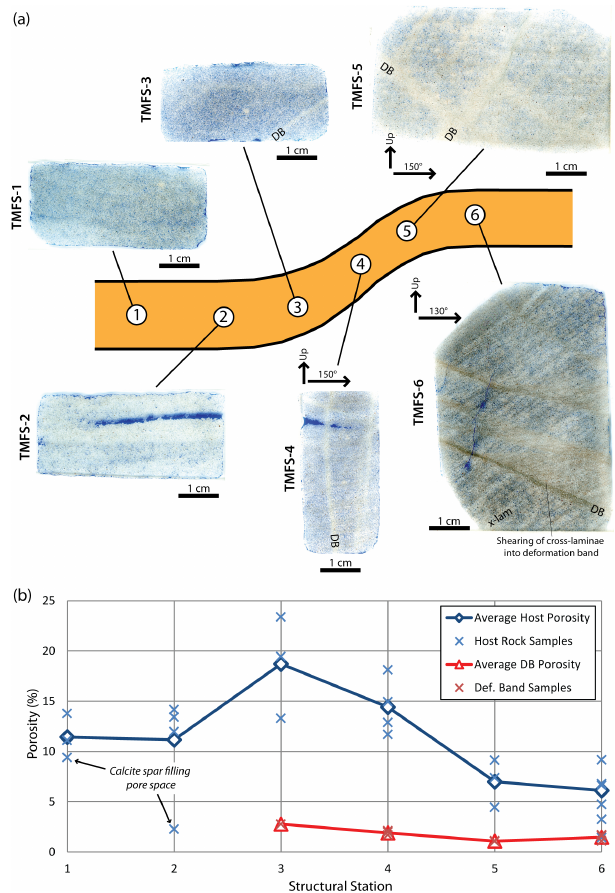
Figure 8. Porosity variability across the intrusion margin. (a) Whole thin-section photographs (flatbed scans) for each structural station. Blue dye denotes porosity in each sample. (b) Plot showing vari- ability in porosity observed in this study for each station. Porosity percentages were calculate using the image analysis software pack- age ImageJ as shown in Fig. 6. Note, a similar porosity reduction trend has been observed previously (see Fig. 8 in Morgan et al., 2008). DB: Deformation Band; X-lam: